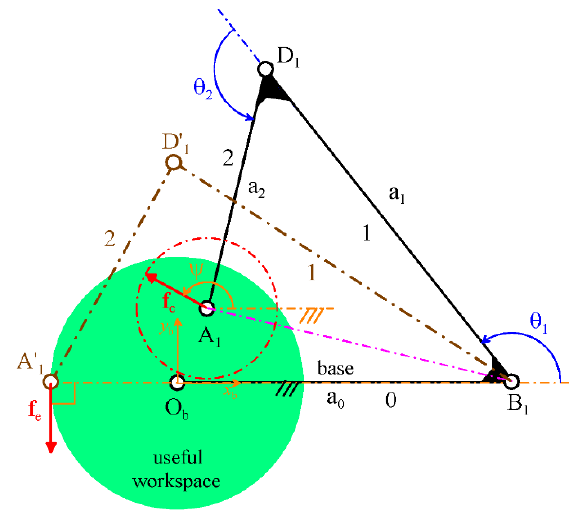
Figure 3. Static problem to solve in case (a).